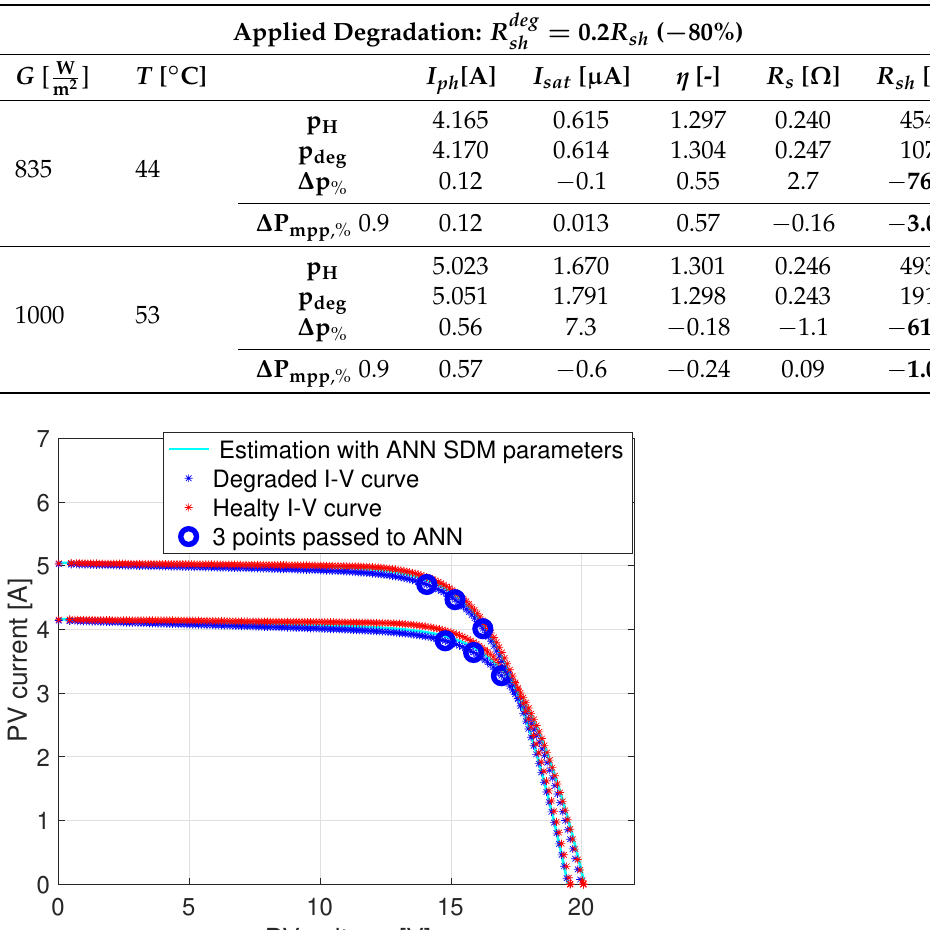
Table 9. SDM parameters estimated with ANN for I - V curves of Figure 17.